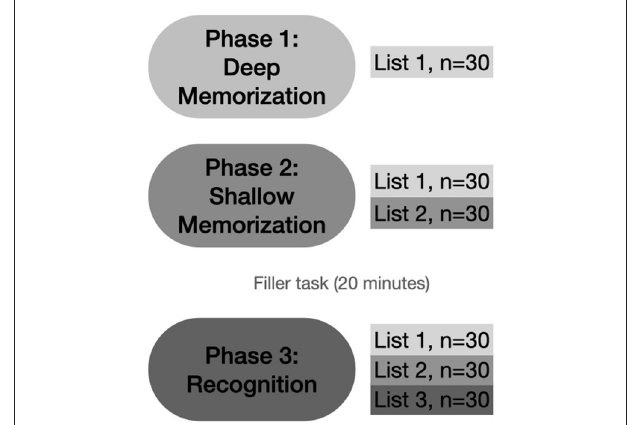
FIGURE 2 | Schematic overview of the experimental design. Phase 1: deep memorization with the pre-experimentally unfamiliar abstract figures and non-words in separate tests using a mnemonic encoding task (redrawing the abstract figures and mentioning rhyming words for the non-words). The 30 stimuli used here form List 1 (drawn/semantically processed stimuli). Phase 2: shallow memorization with the instruction to remember as many stimuli as possible. This phase contained items from List 1 and 30 new ones (List 2, studied stimuli). Phase 3: recognition of the stimuli including List 1, List 2, and